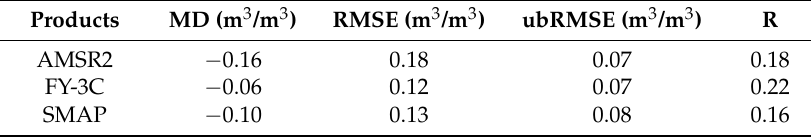
Table 6. The spatial statistical indices for FY-3C, AMSR2, and SMAP against the in-situ measurements.